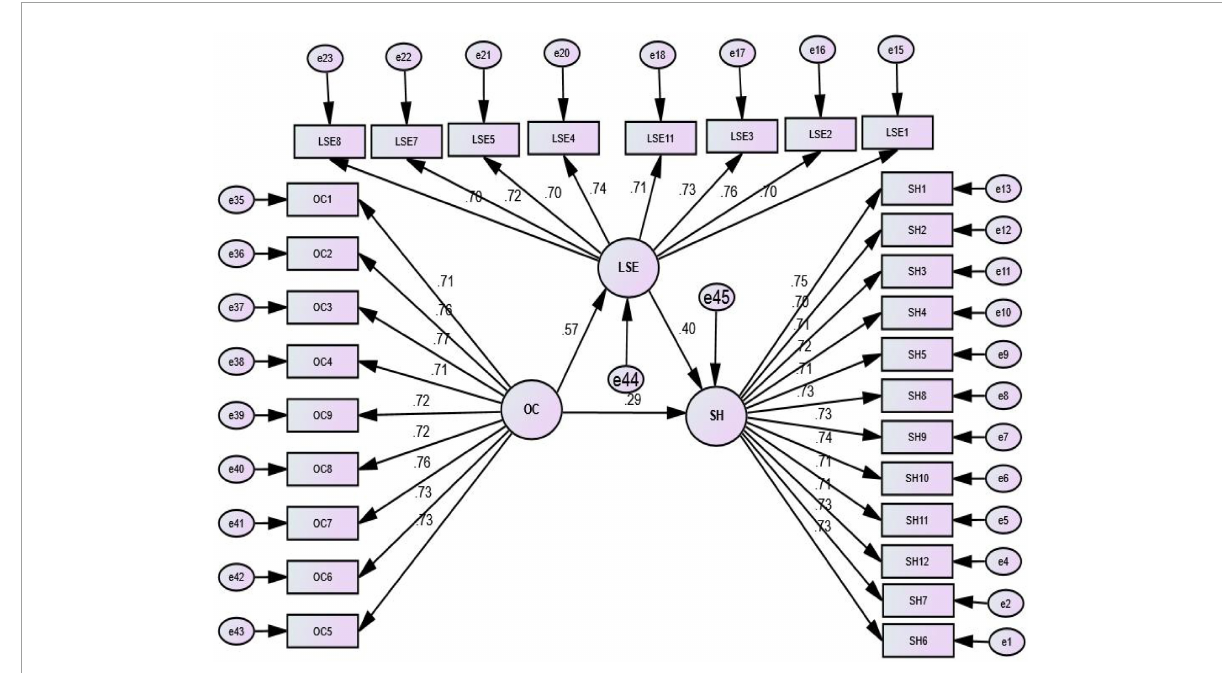
FIGURE2 Relationship between organizational climate (OC) and sexual harassment (SH) by the mediator.